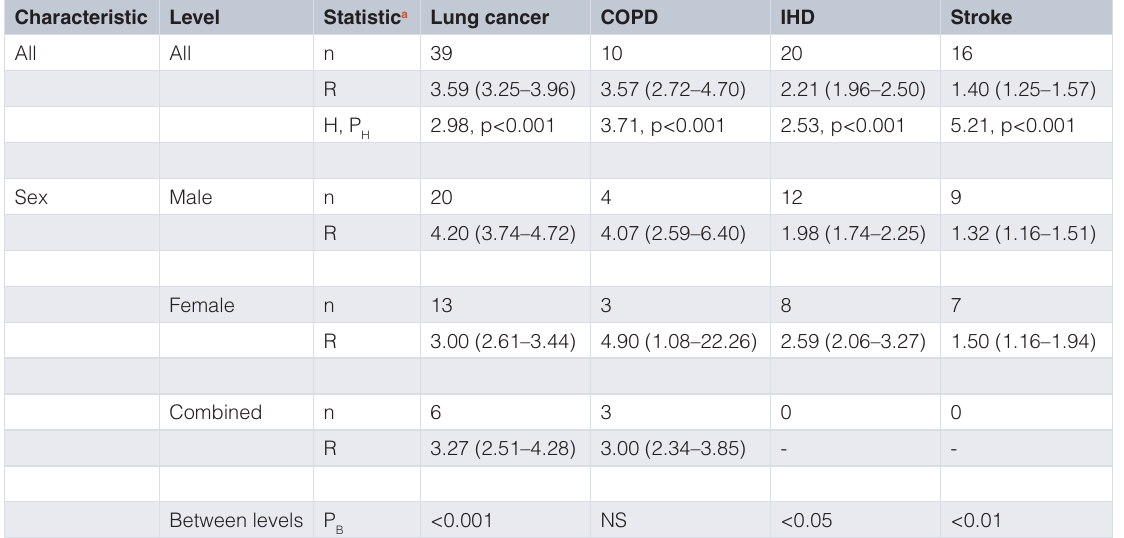
Table 3. Meta-analyses for current